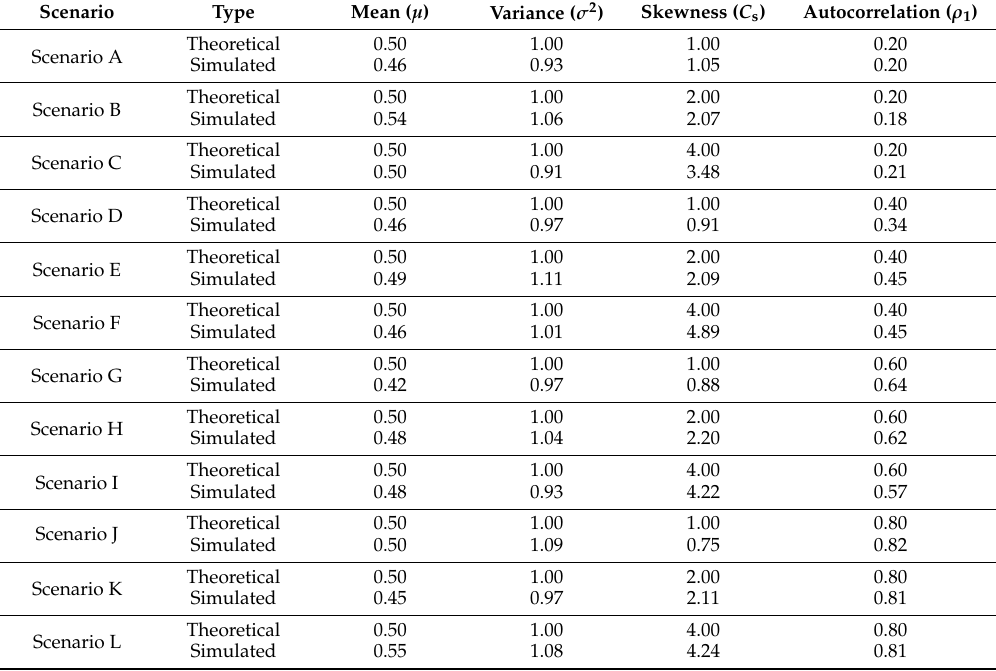
Table A1. Scenario-based summary of theoretical (see Table 1 of the main manuscript; Section 2.2— “The envelope behavior in the classical univariate AR(1) model”) and simulated (synthetically generated; using an AR(1) with P III white noise)